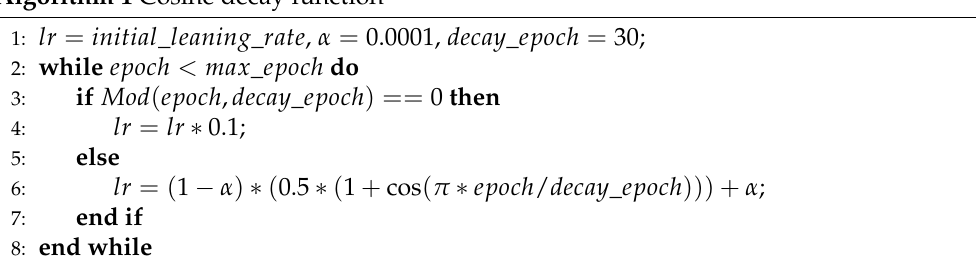
Algorithm 1 Cosine decay